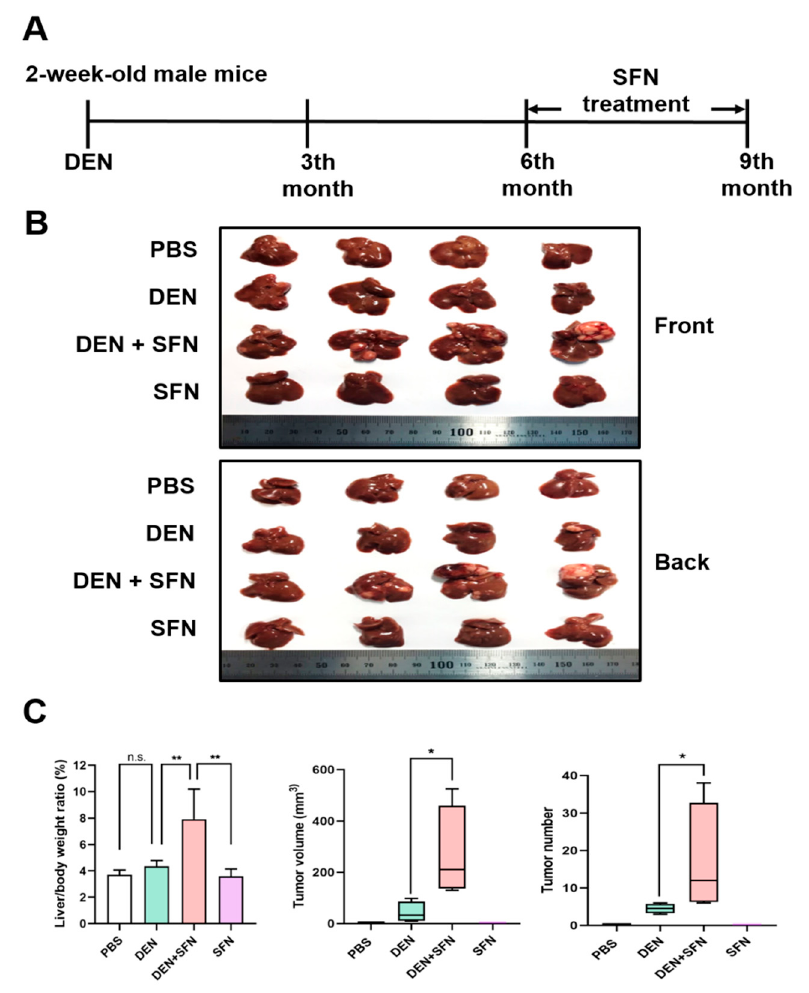
Figure 2. Effects of SFN on DEN-induced hepatocarcinogenesis. ( A ) Two-week-old male mice ( n = 4) were given a single intraperitoneal dose of DEN (25 mg/kg) prepared in PBS. Six months after DEN administration, SFN was daily injected intraperitoneally (25 mg/kg) for 3 months. ( B ) At 9 months after DEN administration, mice were killed, and livers were isolated. ( C ) Body weight, liver weight, tumor volume, and tumor number were measured. The statistical significance was determined by the two-tailed unpaired Student’s t test. Data are shown as the mean ± SD ( n = 4). * p < 0.05; ** p < 0.01; n.s.: